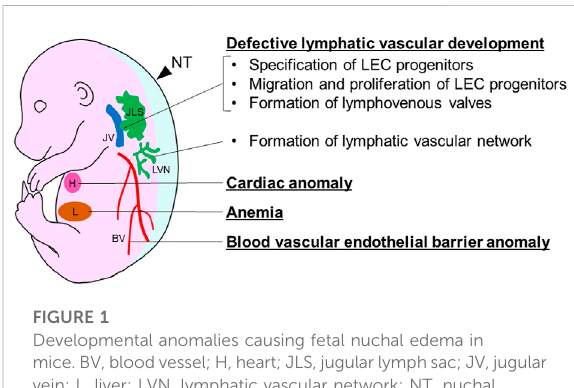
FIGURE 1 Developmental anomalies causing fetal nuchal edema in mice. BV, blood vessel; H,heart; JLS, jugular lymphsac; JV, jugular vein; L, liver; LVN, lymphatic vascular network; NT, nuchal